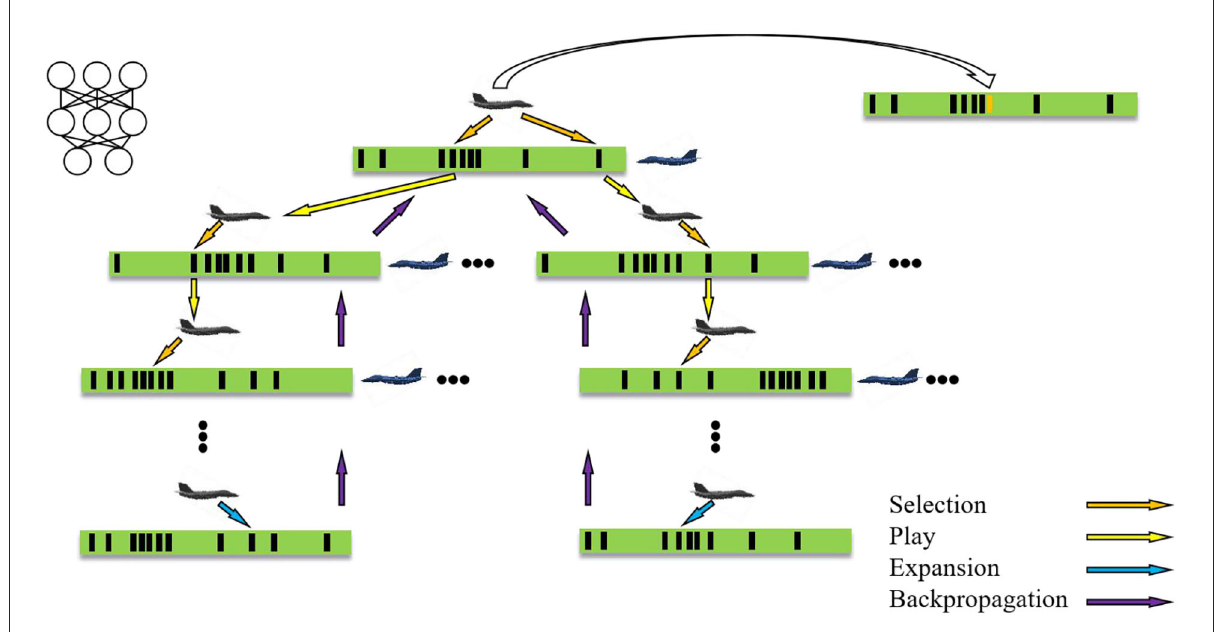
FIGURE2 MCTS in continuous space.